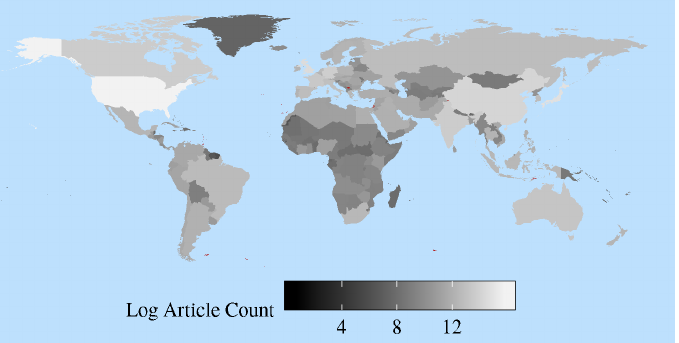
Figure 3. RDNF Articles by Country . Note: Of the approximately 40 million initial RDNF articles, after filtering we obtained approximately 20 million articles related to economics and finance written in English. We kept articles containing economics and finance terms and dropped articles containing sports terms, then implemented the R package newsmap (Watanabe 2018), a semi-supervised Bayesian model, to tag articles to specific countries. The figure shows the country coverage of RDNF log- transformed article counts from January 1996 to July 2021. The lighter colors represent countries with a relative abundance of articles in the dataset; only countries in Africa and the Middle East have relatively low coverage of economics and finance